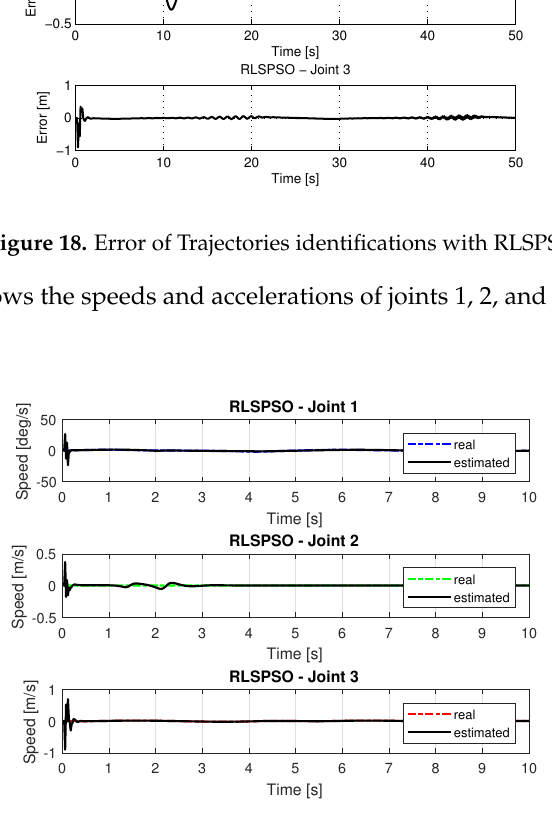
Figure 19. Speed of joints with